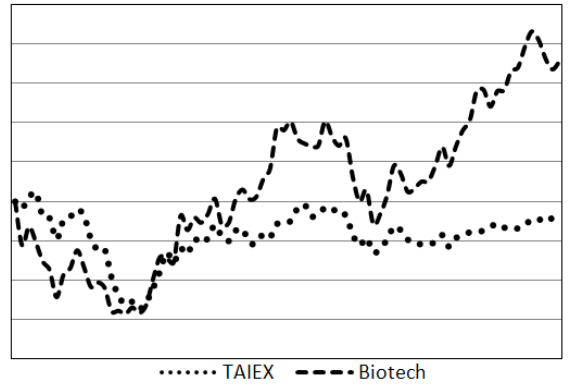
Fig. 1. TAIEX and Biotechnology Index